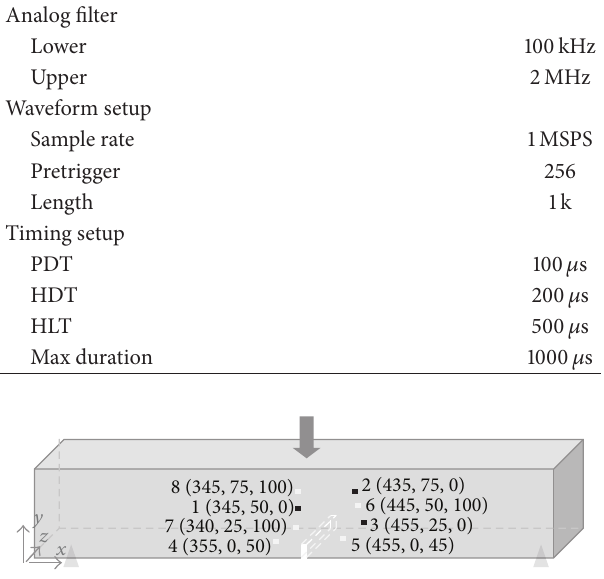
Figure 5: Coordinates system setup and sensors location.